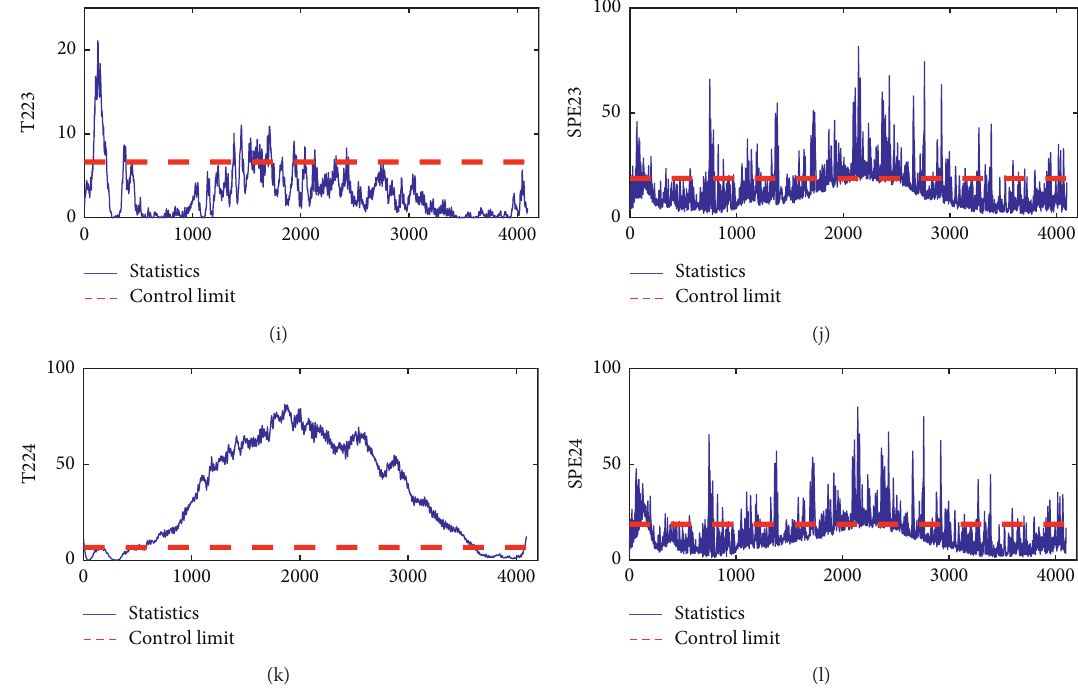
Figure 6: Case Western Reserve University bearing inner ring failure results based on Deep EMD-PCA.